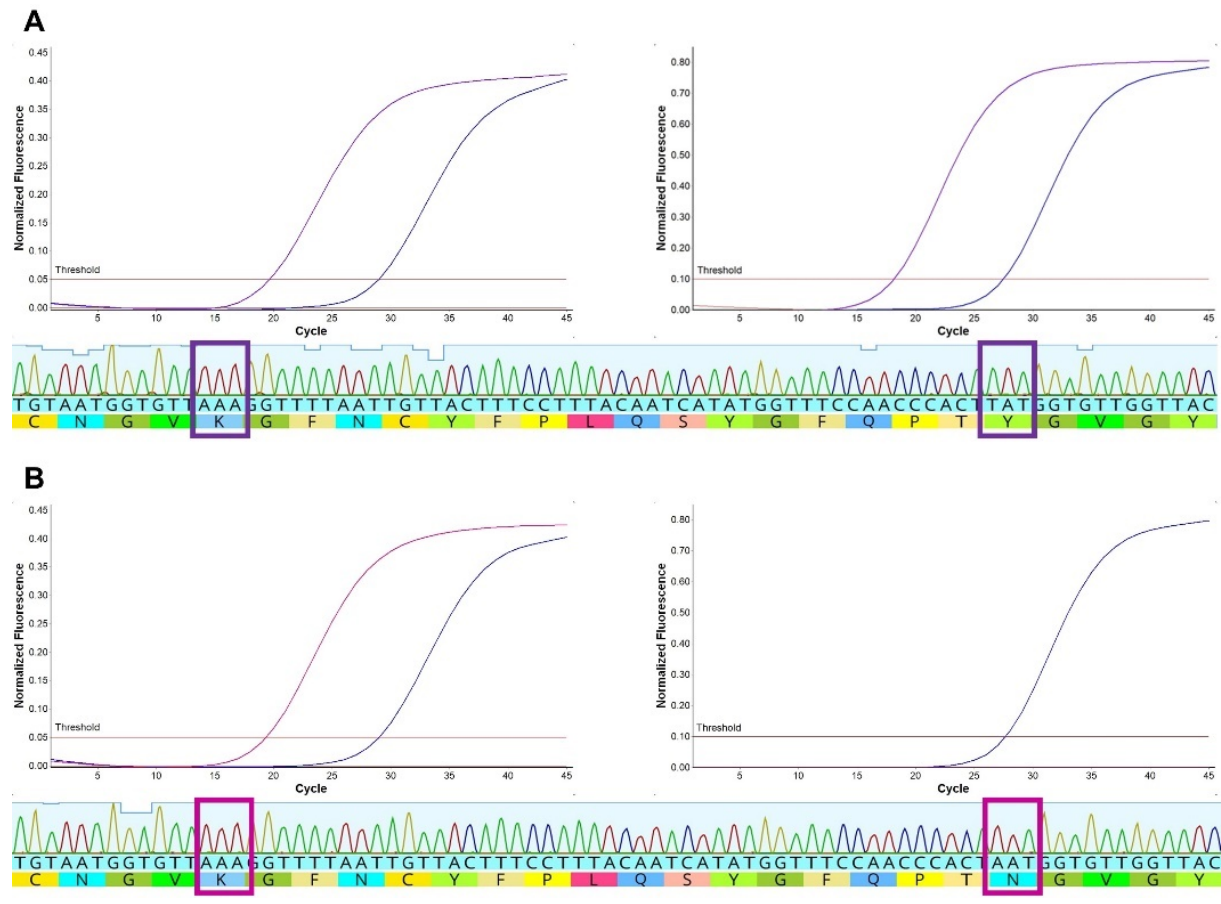
Figure 4. Spike SNP and amplicon sequencing results were concordant. Amplification curves and amplicon sequence tracings are shown for samples with mutations encoding ( A ) 484K and 501Y (purple curves) or ( B ) 484K only with N501 (cranberry). A beta variant control sample is shown for reference (blue curves). Bold squares highlight the SNP mutations in the amplicon sequence.